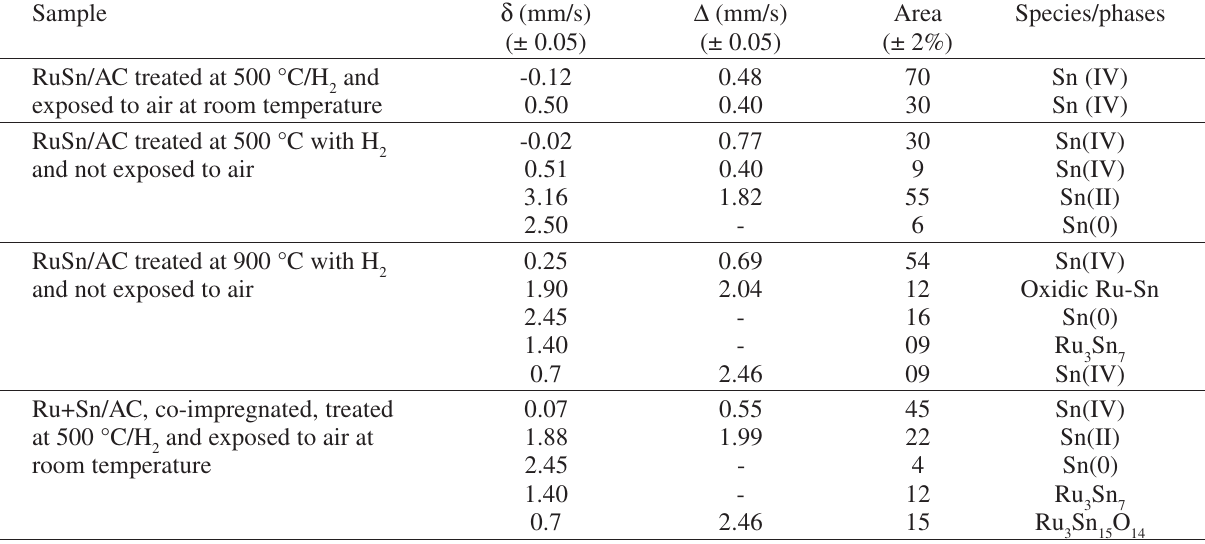
Table 1. 119 Sn Mössbauer parameters obtained at 23 K for the carbon supported RuSn catalysts submitted to different treatments.